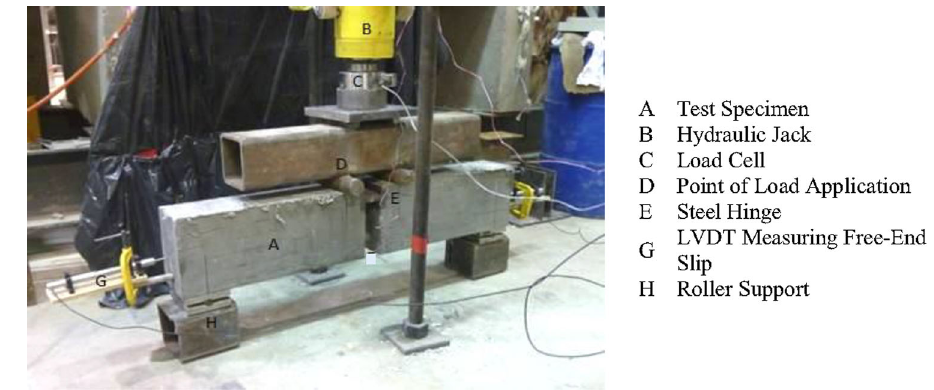
Fig. 6 Test setup for beam